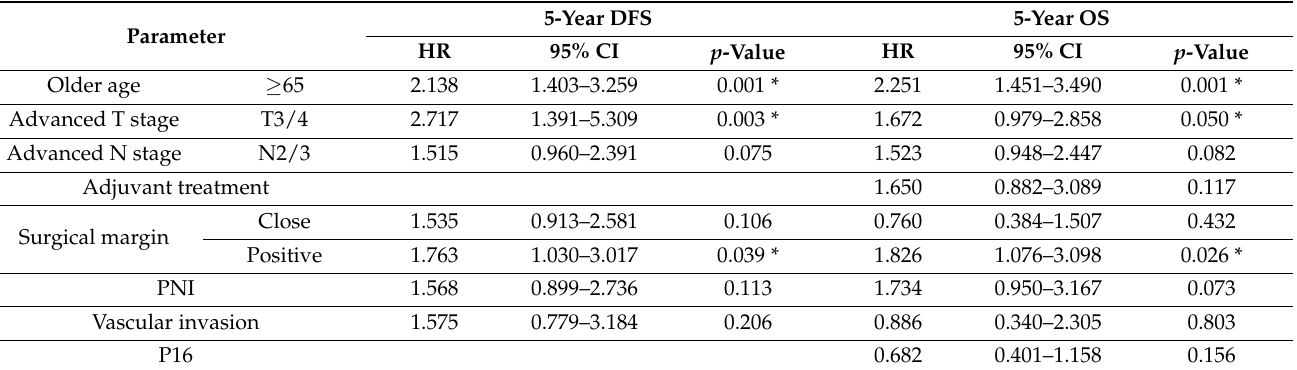
Table 4. Multivariate analysis of recurrence and overall survival in patients with oral/oropharyngeal cancers ( n = 418).